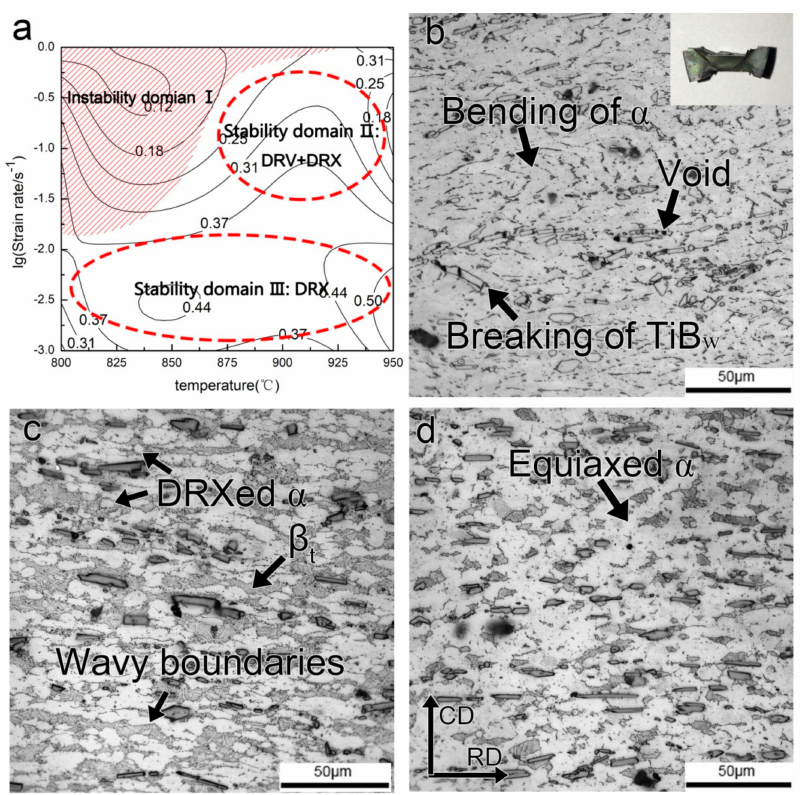
Figure 11. The processing map ( a ) and the microstructure of 7.5 vol.% TiB w / near α -Ti composite in instability and stability domains: ( b ) 800 ◦ C / 1 s − 1 , ( c ) 950 ◦ C / 0.1 s − 1 , ( d ) 900 ◦ C / 0.001 s − 1 . (The shadow domain represents the instability